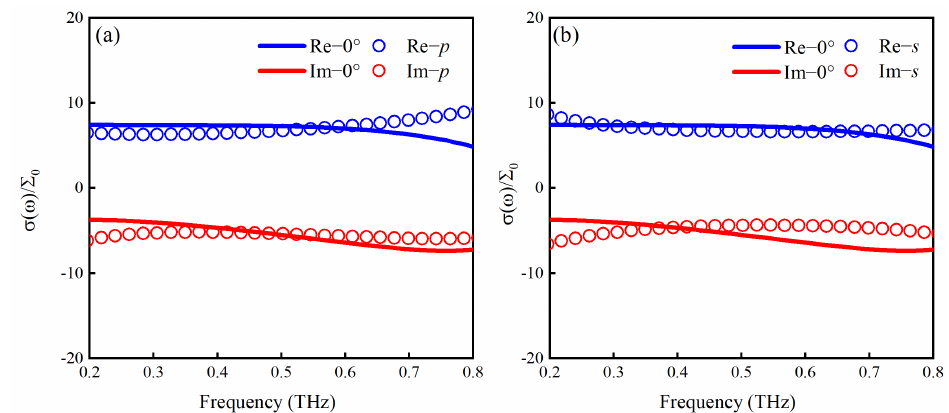
Figure 6. ( a ) The optical conductivity of 8L MoS 2 extracted from the TDTS at θ in = 20 ◦ for p - polarization and ( b ) s - polarization. The result for θ in = 0 ◦ is also shown for